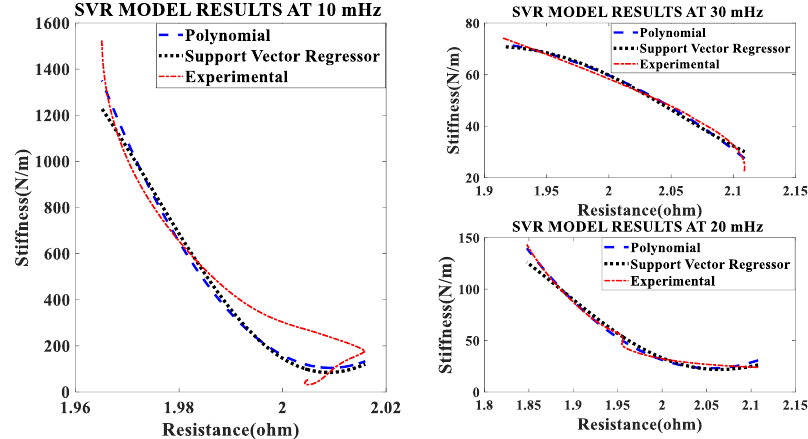
Figure 4. Comparison of models of self-sensing stiffness characteristics with experimental result at different excitation frequencies.